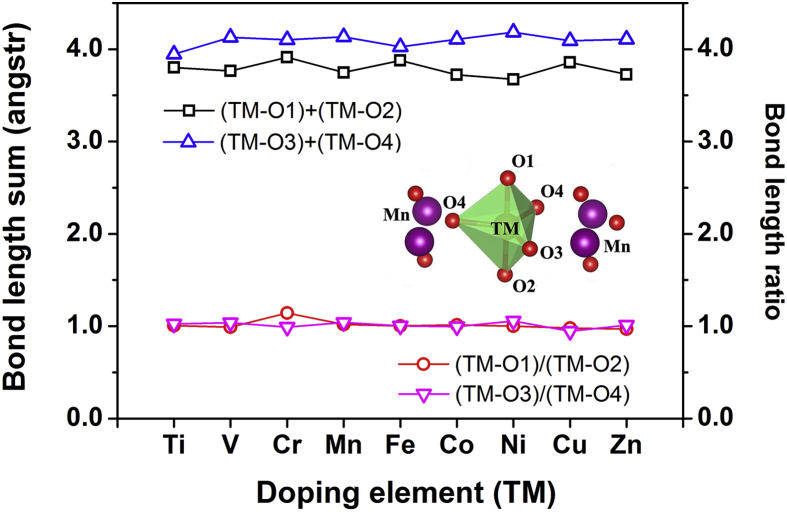
Bond length sums and bond length ratios for TMO5 bipyramids in hexagonal YMn0.917TM0.083O3 bulks dependence on doping elements (TM) from Ti to Zn. The inset is the structural representation of TMO5 bipyramid.